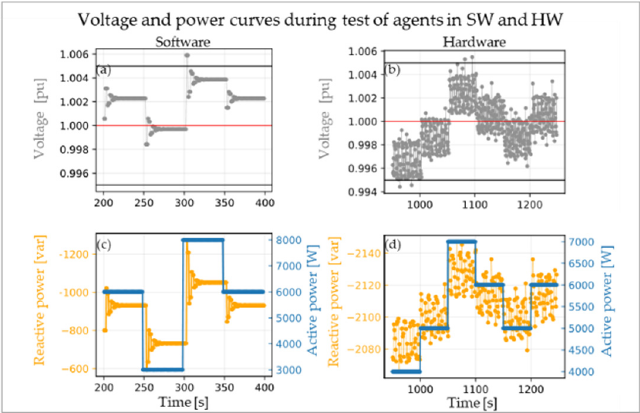
Figure 5. Mean reward R mean of the agents increasing throughout training in software (SW) and hardware (HW).